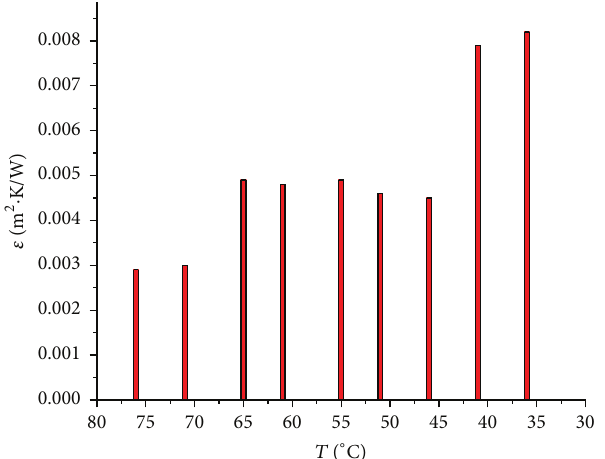
Figure 8: Changing regulation of 𝜀 with respect to the temperature of outer wall in experiment II.